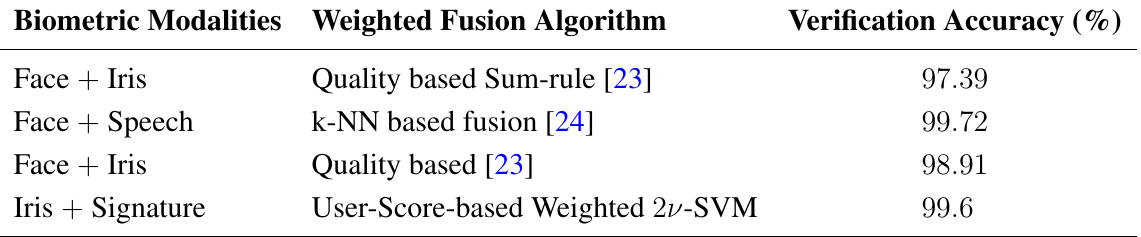
Table 3. Comparative table of the weighted based fusion